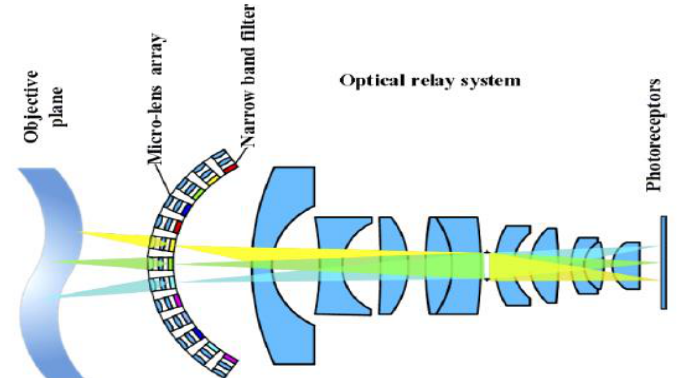
Figure 46. The cross-sectional schematic of the MCCEC.